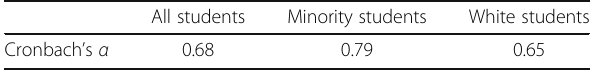
Table 11 Reliability statistics for motivations to persist All